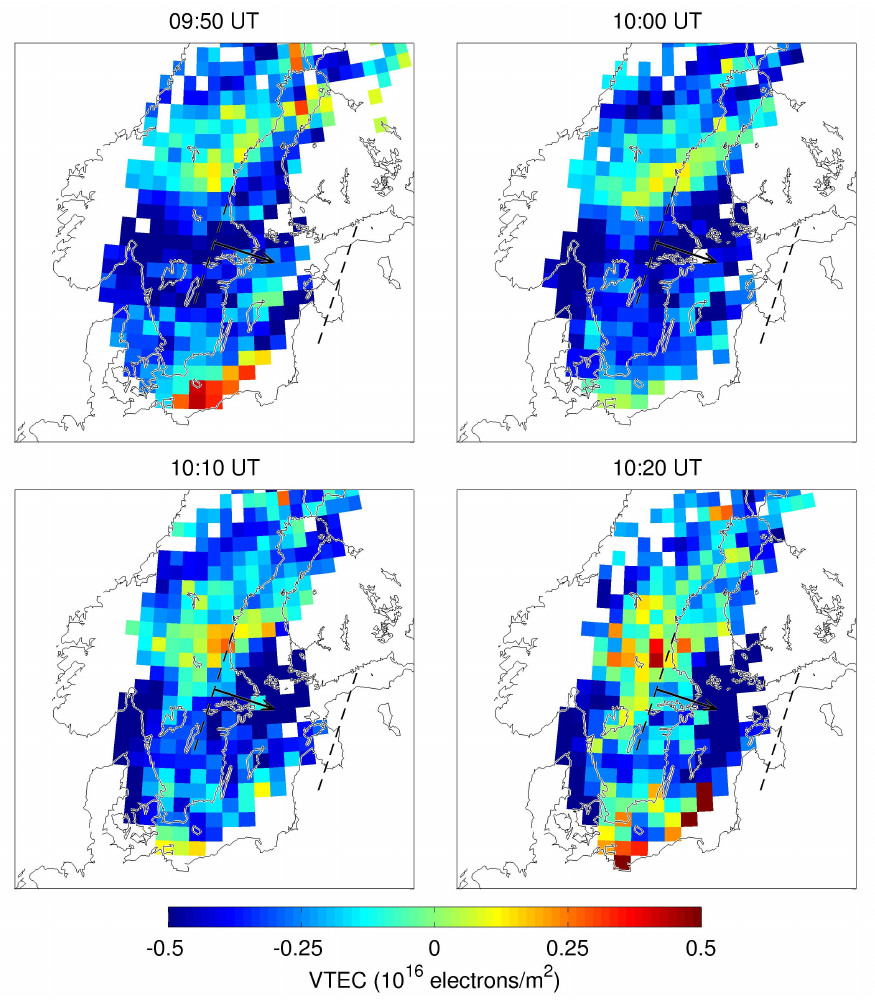
Figure 17. The TEC derived from the GPS data in a 2-D horizontal grid, and the wave properties of the detected TIDs superimposed on the plots, at four times on 20 January 2010. The parameters of the detected wave are α x = 108 ◦ , λ x = 500km, v x = 67.2ms − 1 .